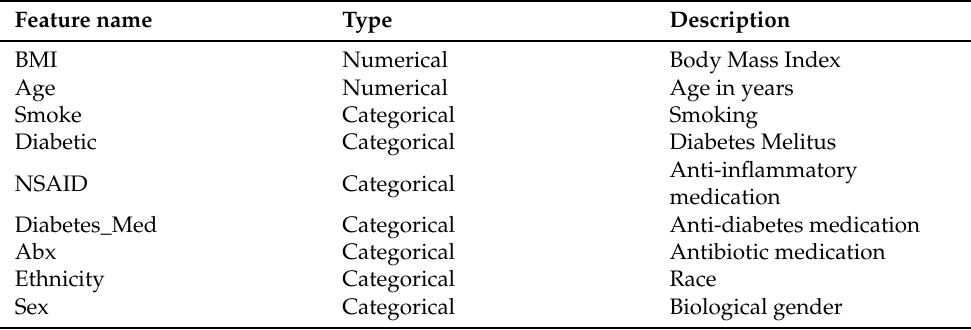
Table A4. List of features included in the colorectal cancer clinical view